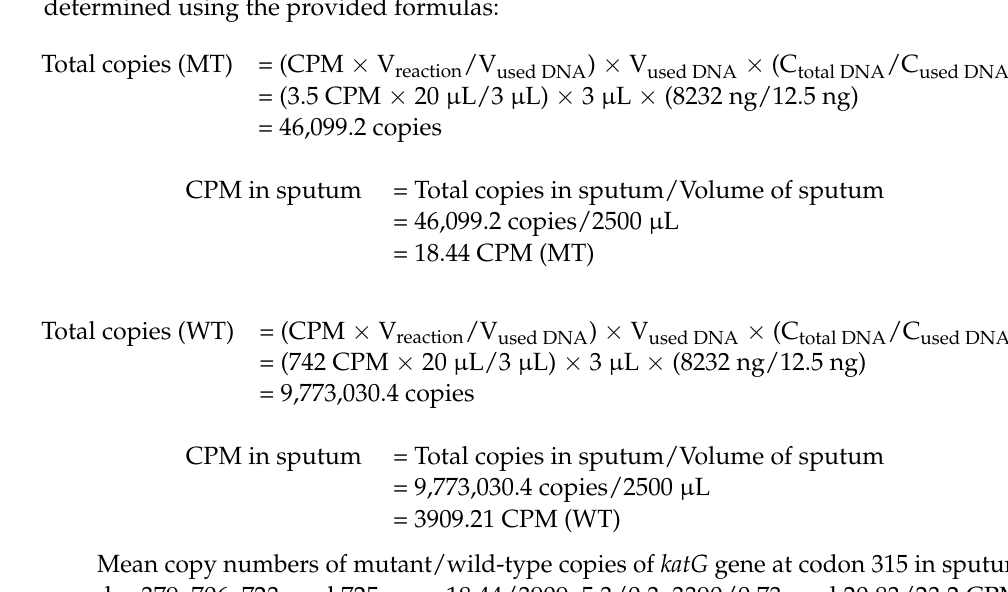
Figure 2. One D amplitude of ( a ) channel 1, FAM; ( b ) channel 2, HEX signals, detecting MT and WT, respectively, of rpoB gene at codon 531 using mutation detection assay for rpoB S531L. The DNA concentration in sputum sample (ID-379) for the katG S315T assay was de-